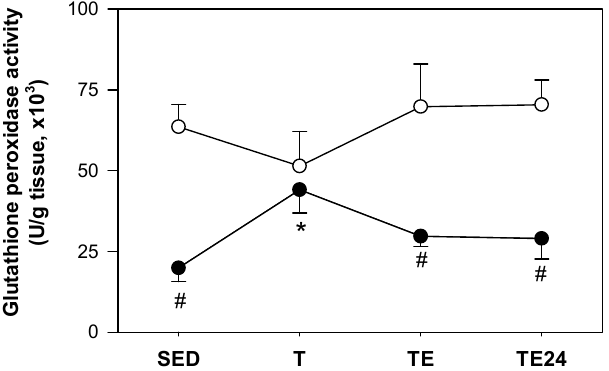
Figure 7. Hepatic glutathione peroxidase (GPx) activity at the end of the study. The non-supplemented groups are represented by white symbols ( ⚪ ) and the hesperidin groups by black symbols ( ⚫ ). SED = sedentary group, T = trained group, TE = T group with an additional exhaustion test, TE24 = TE group 24 h after the exhaustion test. Data are expressed as mean ± SEM ( n = 6–8). Statistical difference (Mann − Whitney U test): # p < 0.05 between non-supplemented and the hesperidin-supplemented groups; * p < 0.05 vs SED group just in the hesperidin animals.